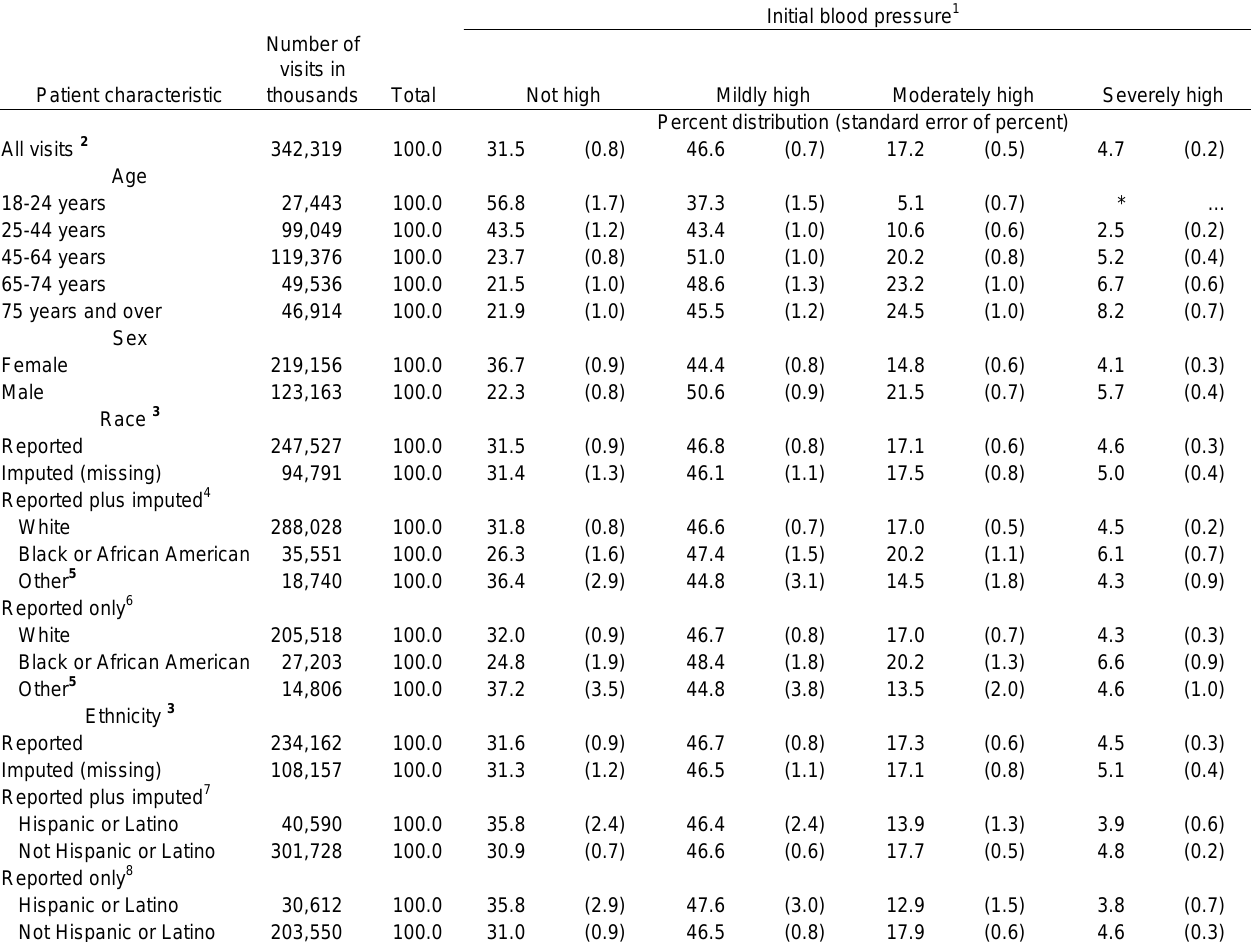
Table 22. Initial blood pressure measurements recorded at office visits to primary care providers for adults aged 18 and over, by selected patient characteristics: United States,